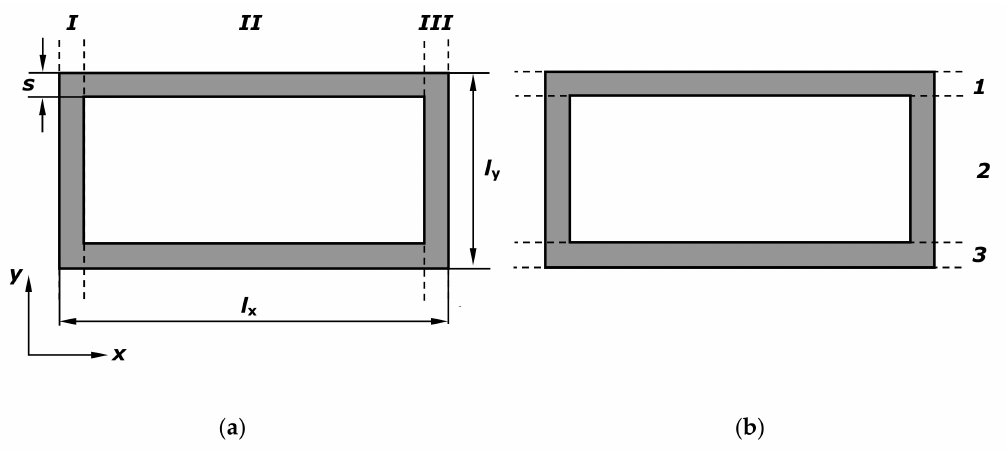
Figure 3. Division of a section into: ( a ) vertical zones I–III, ( b ) horizontal layers